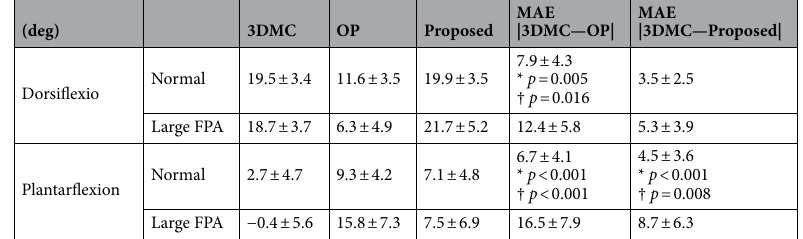
Table 4. Peak ankle joint angles during a gait cycle calculated by 3DMC, OP, and proposed methods in slow speed conditions (mean ± SD). In large FPA condition, participants were instructed to walk with an FPA of 50°. MAE was averaged after calculating the absolute value of the difference between each participant’s data measured by two methods. *Indicates a significant difference compared to self-selected speed with large FPA condition on same MAE ( p < 0.05). † indicates a significant difference compared to slow speed with large FPA condition on same MAE ( p < 0.05).